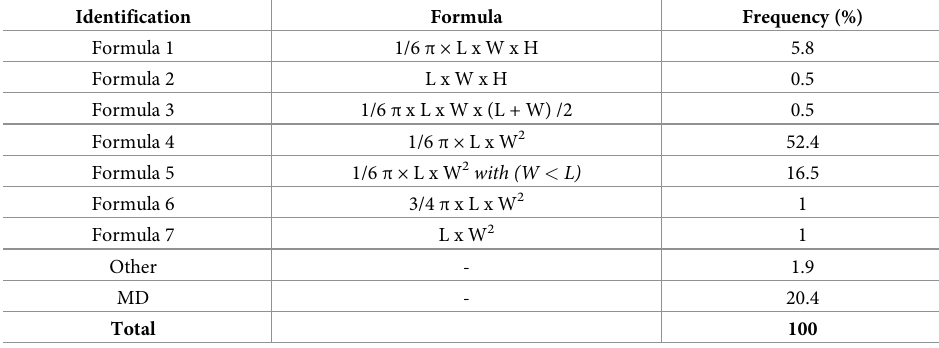
Table 1. Summarize of the seven formulas used in 2019 for tumor volume monitoring on human breast cancer xenograft bearing mice and their frequency of use (n = 206). Identification